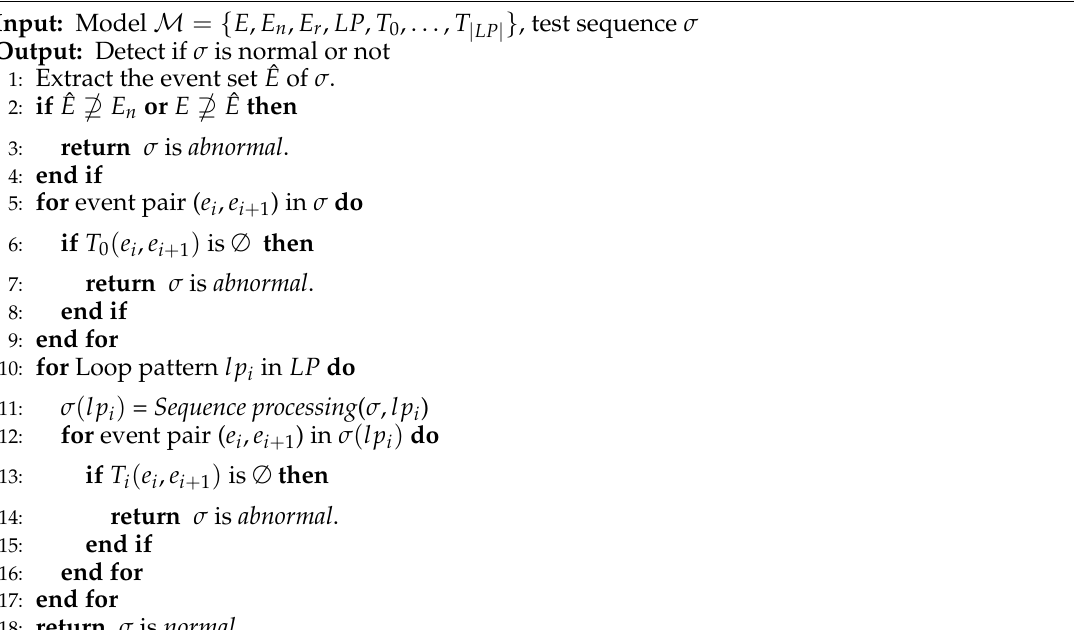
Subroutine 7 Parallel Relation Table Anomaly Detection